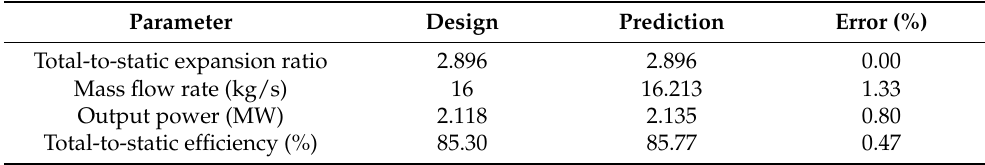
Table 6. Evolution of the one-dimensional design. Parameter